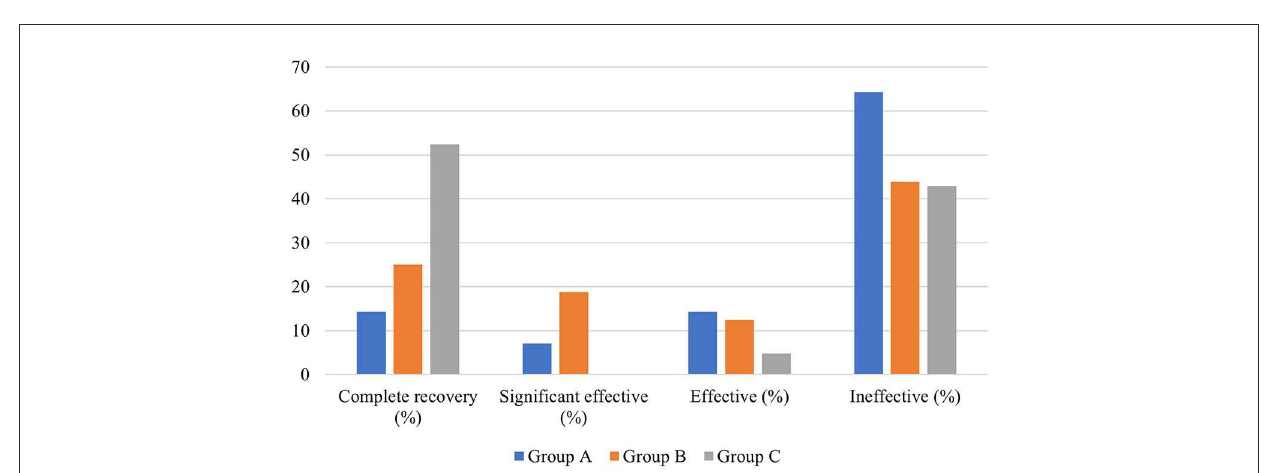
FIGURE6 Hearing efficacy of patients with descending-type SSNHL in the three groups.